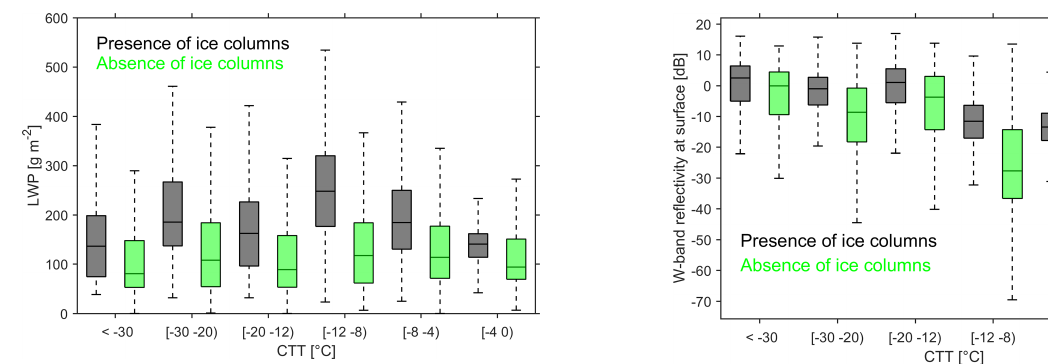
Figure 5. The same as Fig. 4 but for W-band radar reflectivity at the fourth range bin (179m above the